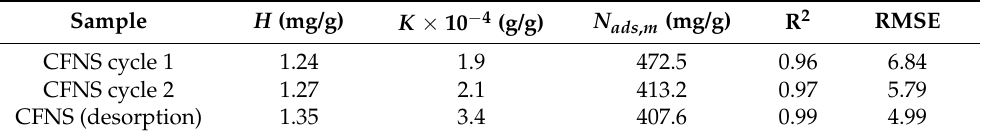
Figure 2. Asphaltene adsorption/desorption isotherm on CFNS, and SLE model correlation at 25 °C. Table 2. Parameters estimated from the solid–liquid equilibrium (SLE) model for n - C 7 asphaltene adsorption/desorption on CFNS.